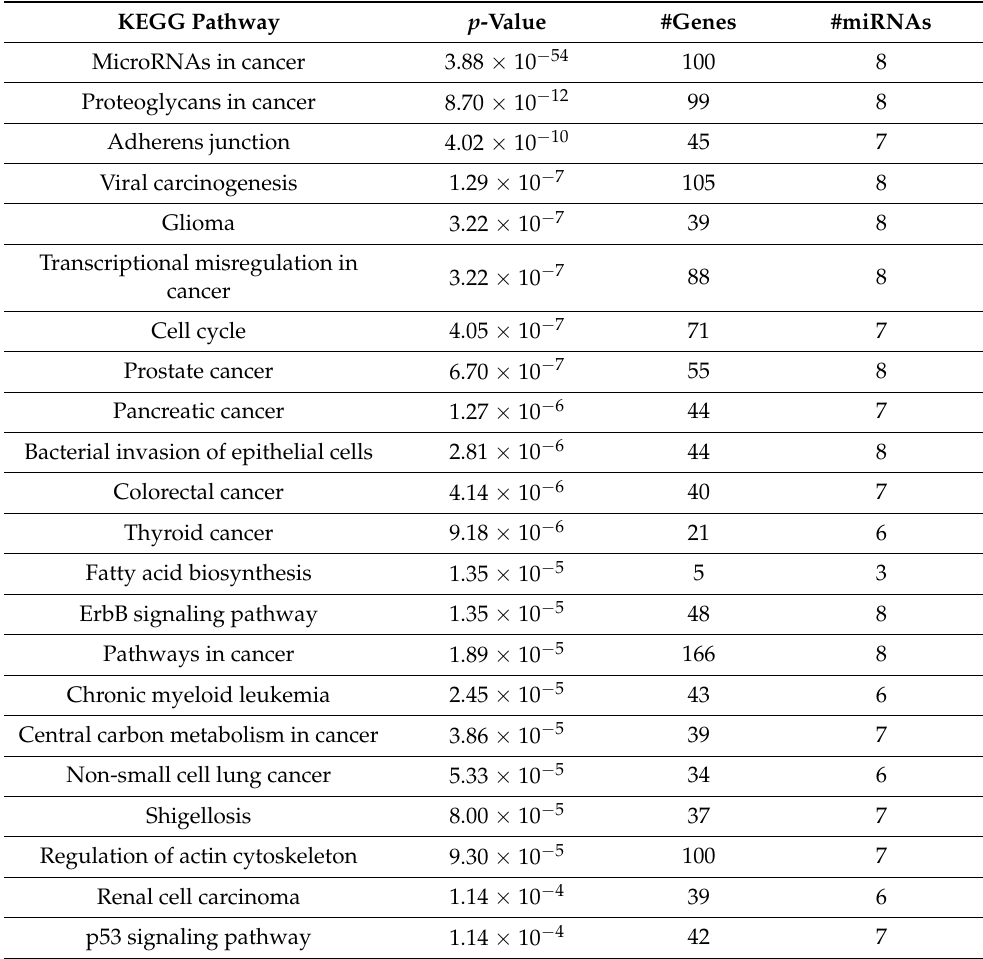
Table 1. KEGG pathways differentially regulated by population-associated miRNAs between AA and EA PCa. MirPath V.3 program was used for identification of the significant signaling pathways regulated by AA-depleted and enriched miRNAs. The significance was measured based on adjusted p -value (FDR < 0.05) determined by statistics implemented in mirPath V.3. KEGG Pathway p